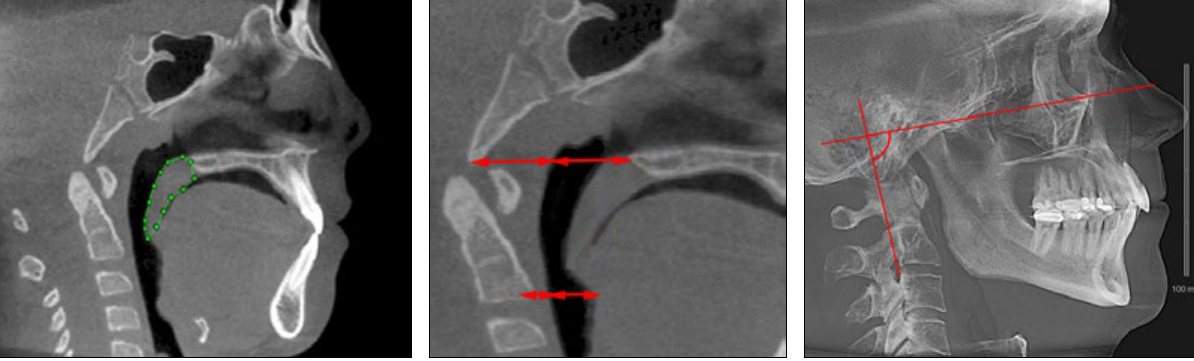
Figure 4. Soft palate surface area. Figure 5. Soft tissue thicknesses and